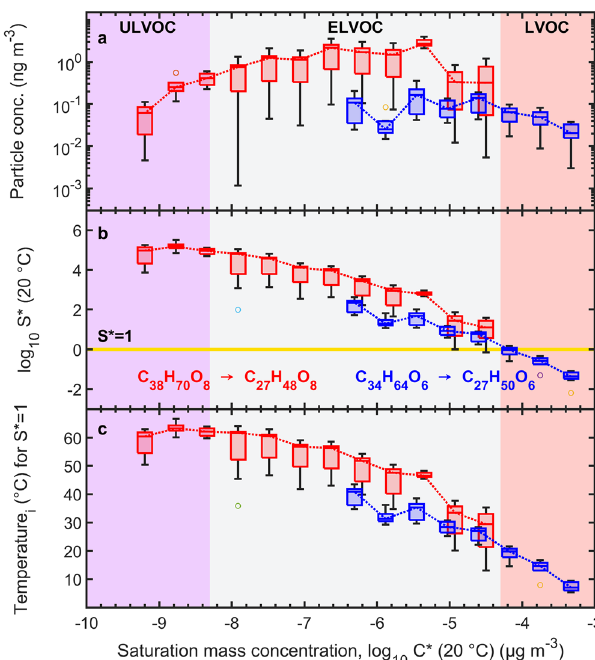
Fig. 3 Ambient concentrations of jet oil esters in the volatility basis set. a Quanti fi ed ambient particle concentration (ng m − 3 ) of each synthetic ester compound (C 27-38 H 48-70 O 8 (red boxes); C 27-34 H 50-64 O 6 (blue boxes)) plotted against the log 10 C (cid:1) i at 20 °C (ULVOC: ultra-low volatility-, ELVOC: extremely-low volatility-, LVOC: low-volatility organic compound). The boxes show the spread of the quanti fi ed mass concentrations (10 – 56 nm) as interquartile range during airport operating hours. The horizontal line within the boxes shows the median and the whiskers show the spread to the most extreme values. Values outside ±2.7 σ are marked as outliers by “ o ” symbols. b Resulting gas-phase saturation ratio S (cid:1) i (20 °C) of the theoretical gas-phase concentration when all particle-phase compounds of ( a ) would partition to the gas phase. Values of S (cid:1) i (20 °C) above 1 (yellow line) indicate supersaturation. c The approximate temperature at which the different jet oil esters reach S (cid:1) i ¼